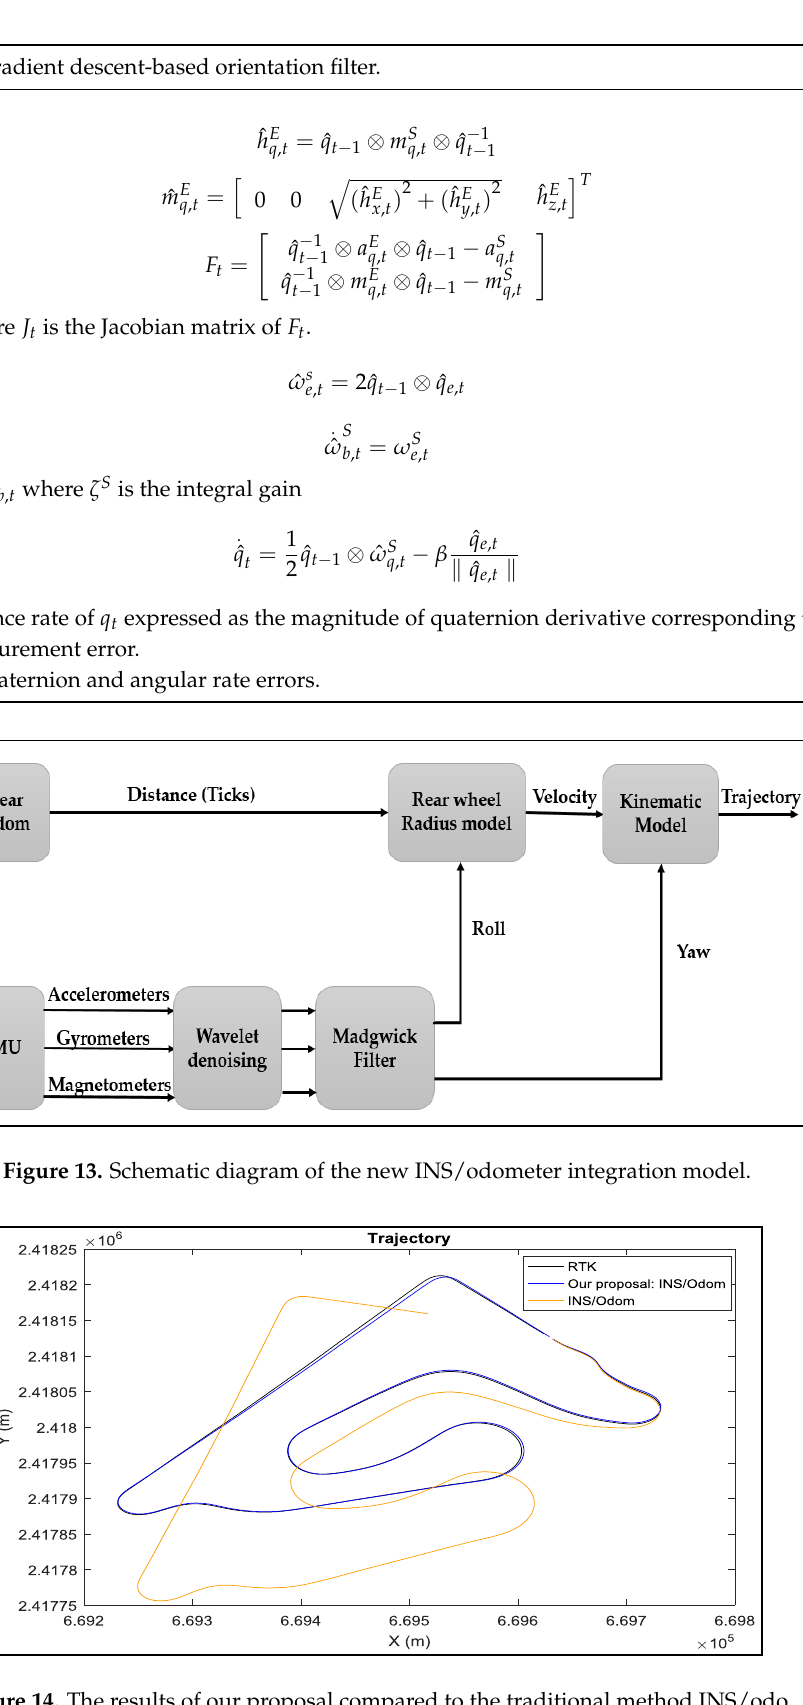
Figure 14. The results of our proposal compared to the traditional method INS/odo.